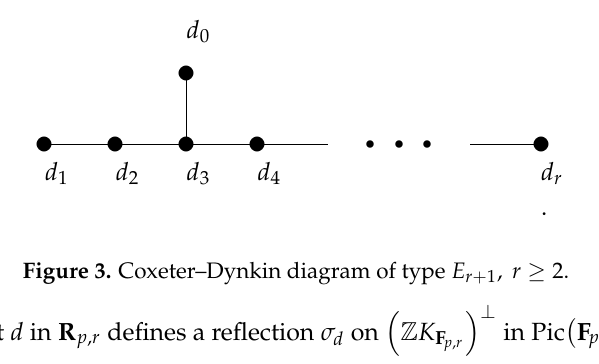
Figure 3. Coxeter–Dynkin diagram of type E r + 1 , r ≥